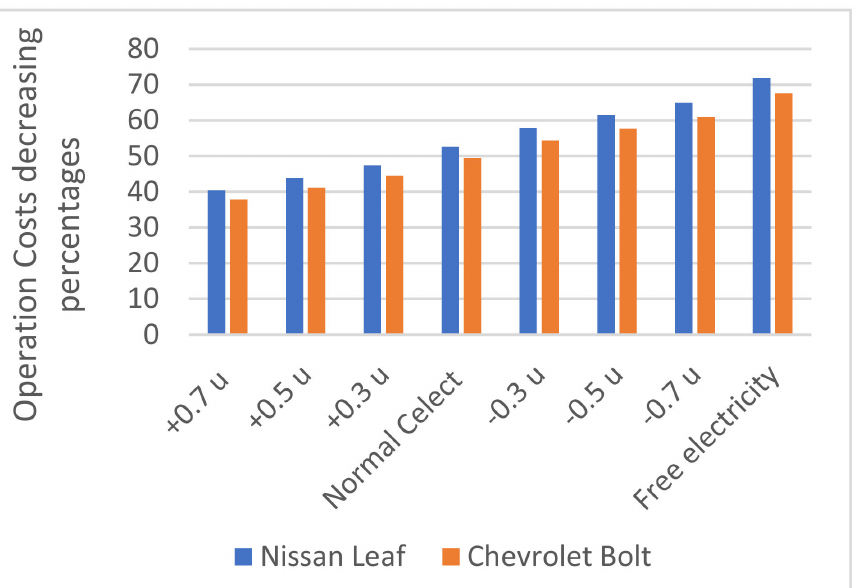
Figure 9. Decrease in the operation cost percentage with electricity variations compared with the Nissan Sentra.